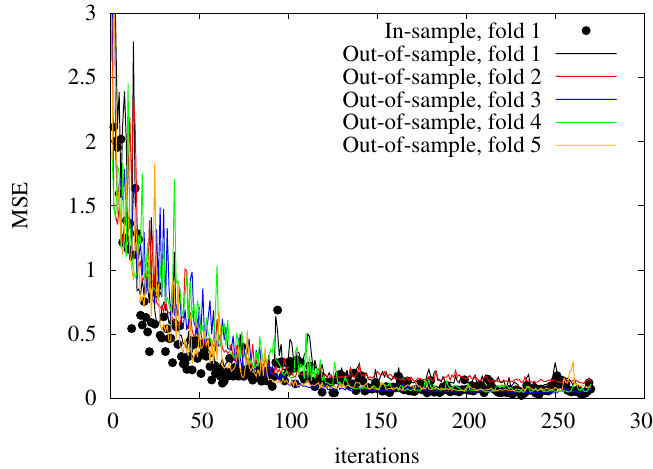
Figure 6. Development of the MSE during